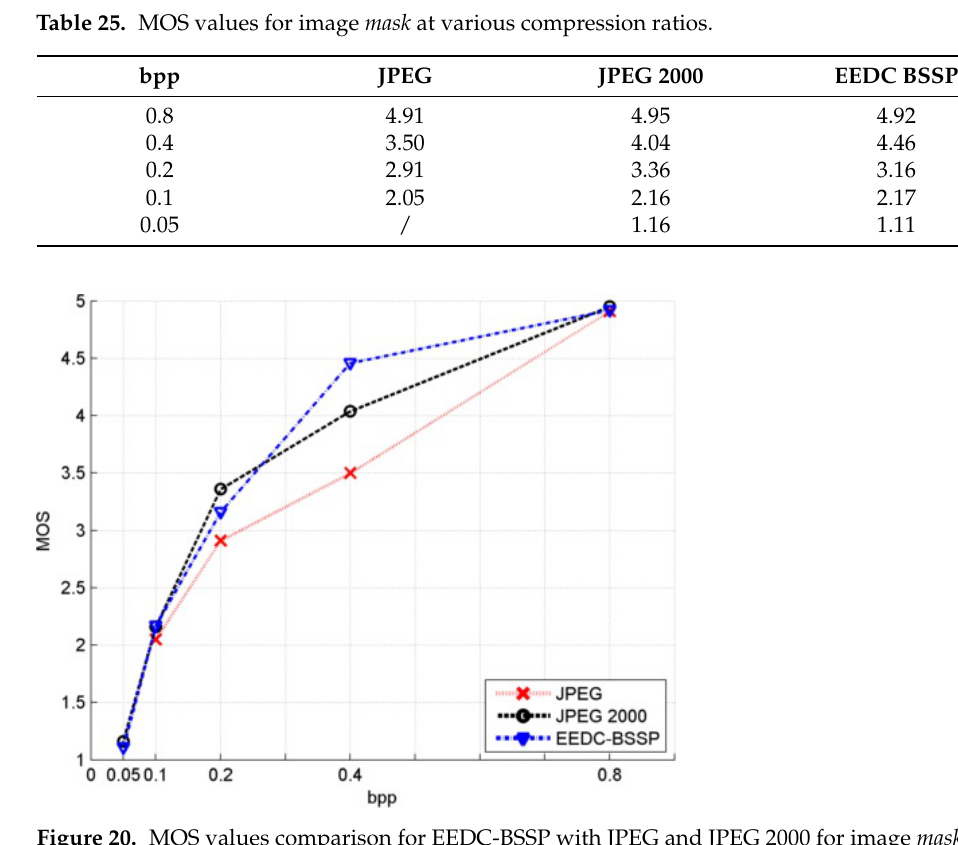
Figure 20. MOS values comparison for EEDC-BSSP with JPEG and JPEG 2000 for image mask .